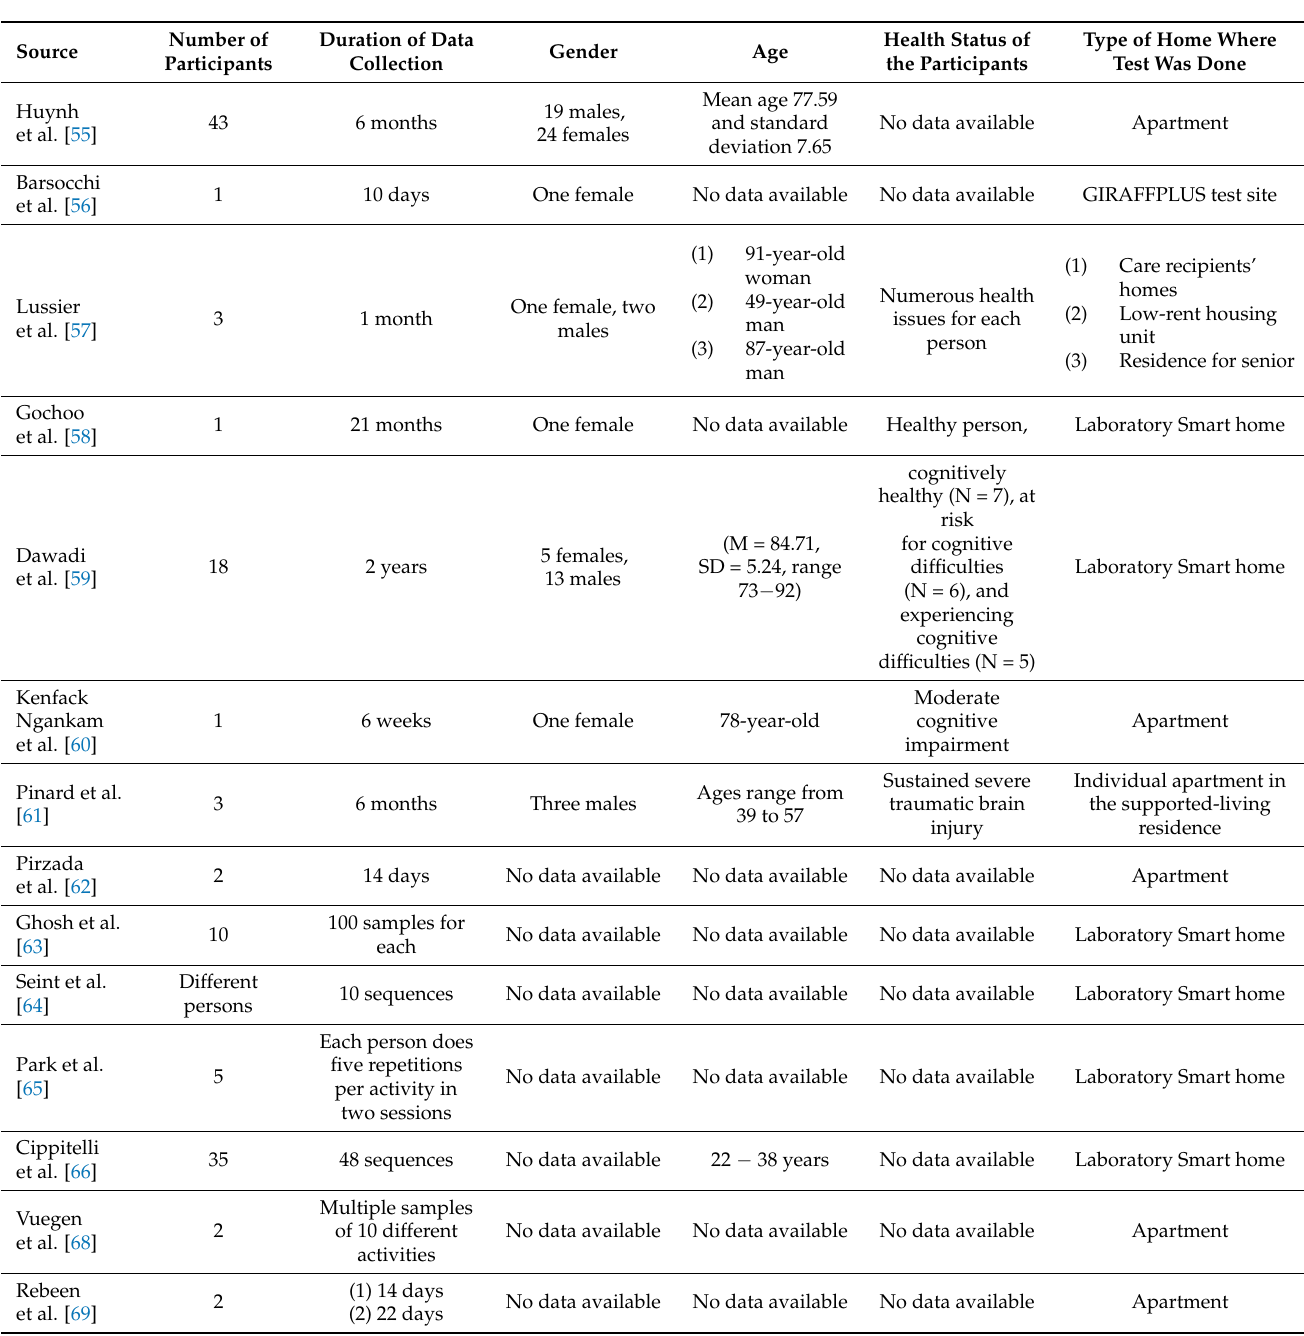
Table 7. Participants, duration and location of data